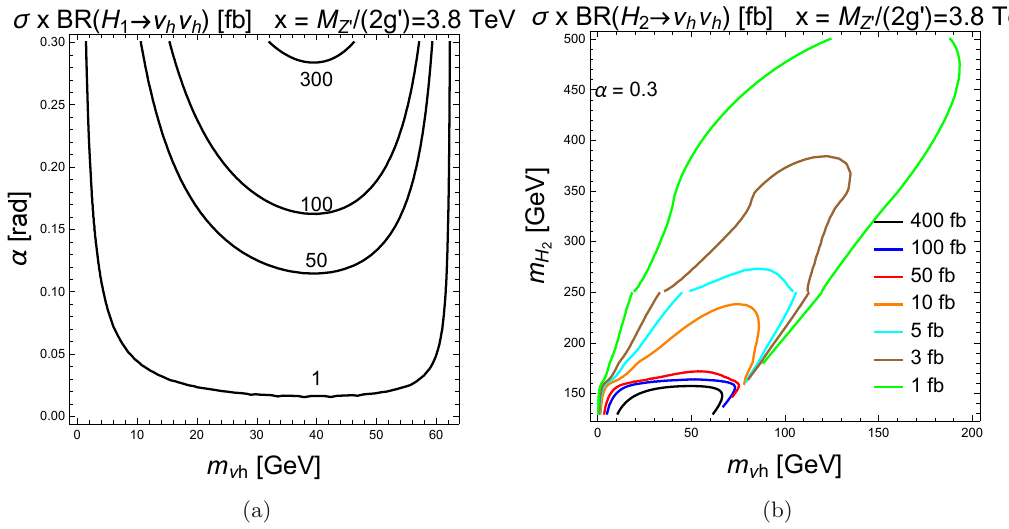
Figure 3 . (a) Contour plots of the cross section times BR for the process pp LHC with √ S = 13 TeV in the ( m ν of the cross section times BR for the process pp the ( m ν , m H ) plane for M Z ′ = 5 TeV and g ′ 2 h